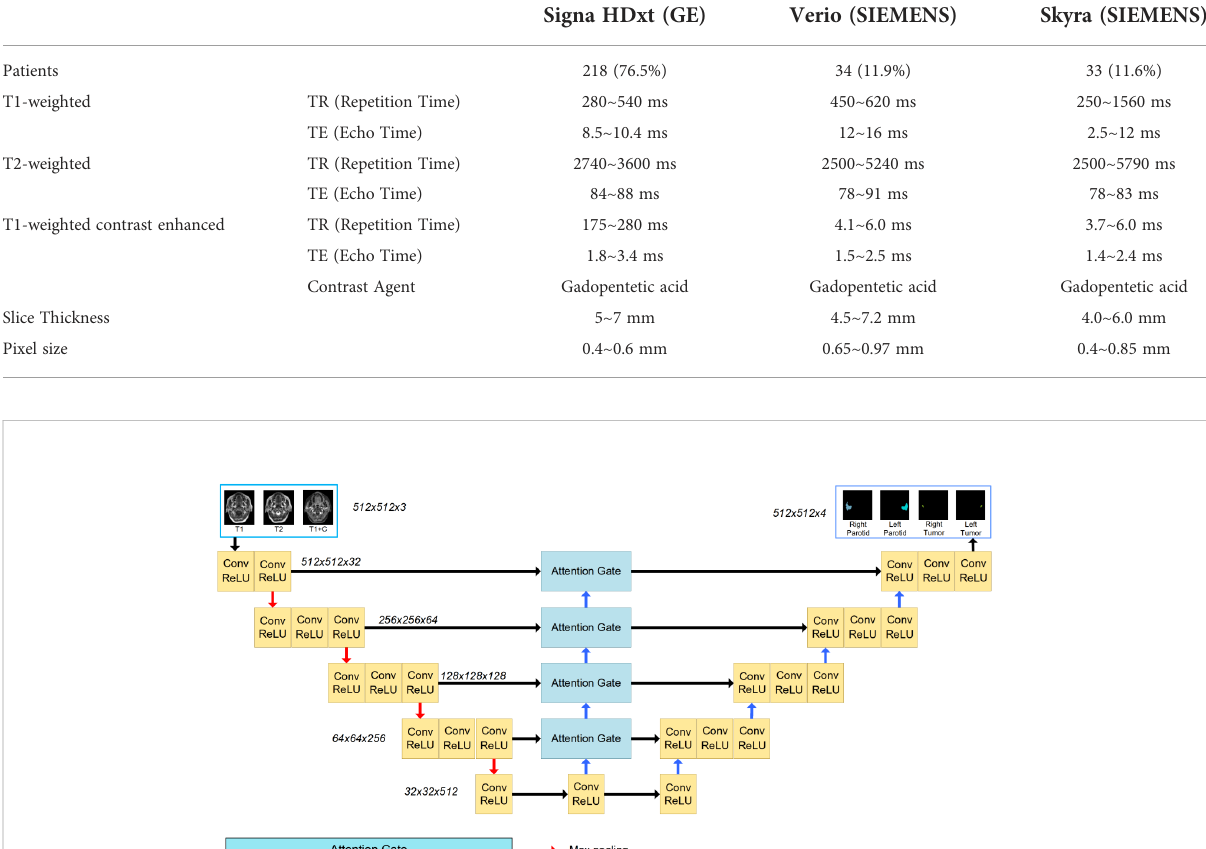
TABLE 2 MR scan parameters.